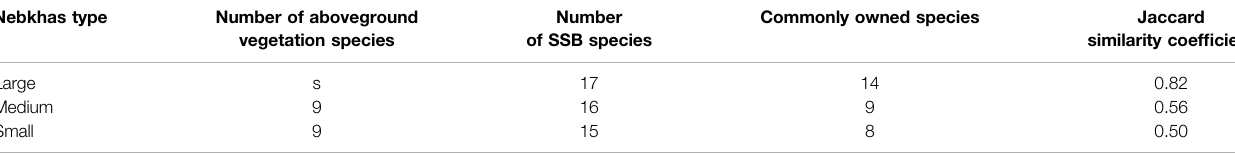
TABLE 4 | Similarity of soil seed bank (SSB) and aboveground vegetation in Nitraria tangutorum nebkhas. Nebkhas type